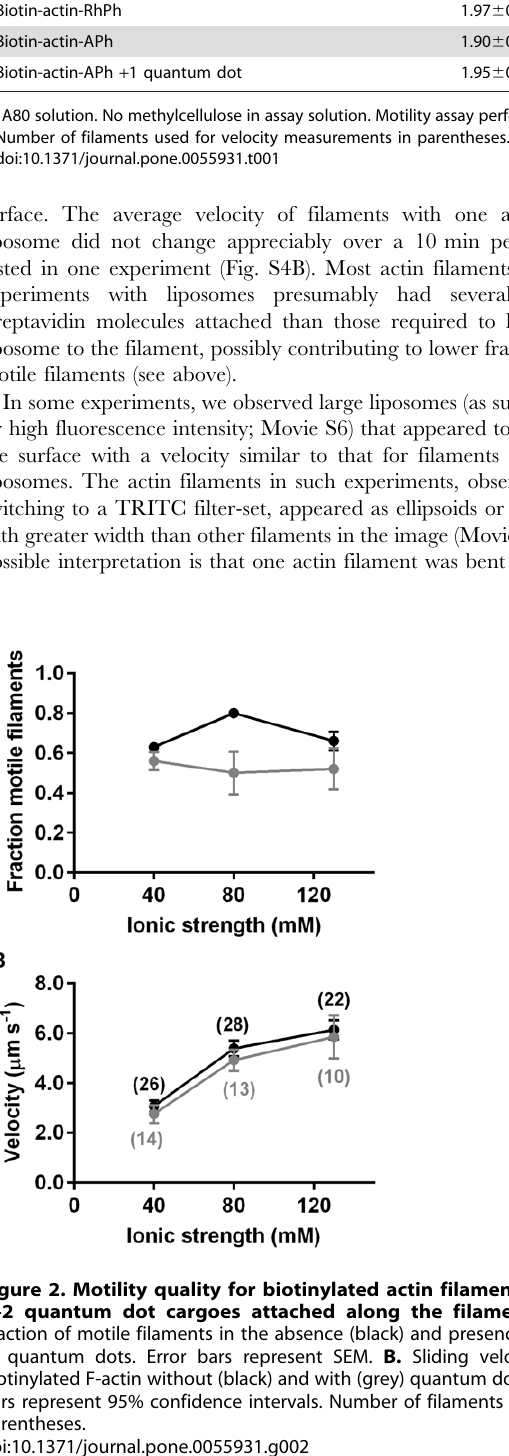
Velocity (mean ± SEM; m m/s) 1 /fraction of motile filaments